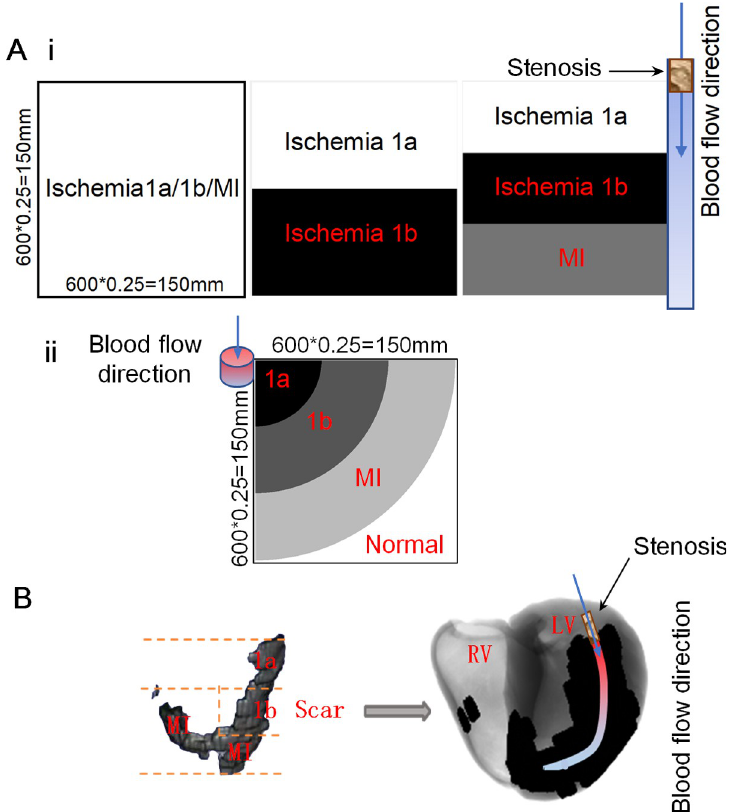
Fig 1. Schematic representation of the tissue models. (A) Tissue architecture of two different distributions of 2D ideal tissues with different pathological areas. (Ai) Distribution of multiple pathological conditions along the direction of blood vessel. The left, middle and right panels in (Ai) represent the tissue with only one pathological condition (left panel), with ischmia1a and 1b conditions (middle panel) and with ischmia1a,1b and MI conditions (right panel), respectively. (Aii) Distribution of multiple pathological conditions on the cross-sectional plane of the blood vessel. (B) Tissue architecture of the 3D real ventricle tissue with ischemia 1a, 1b, MI and normal